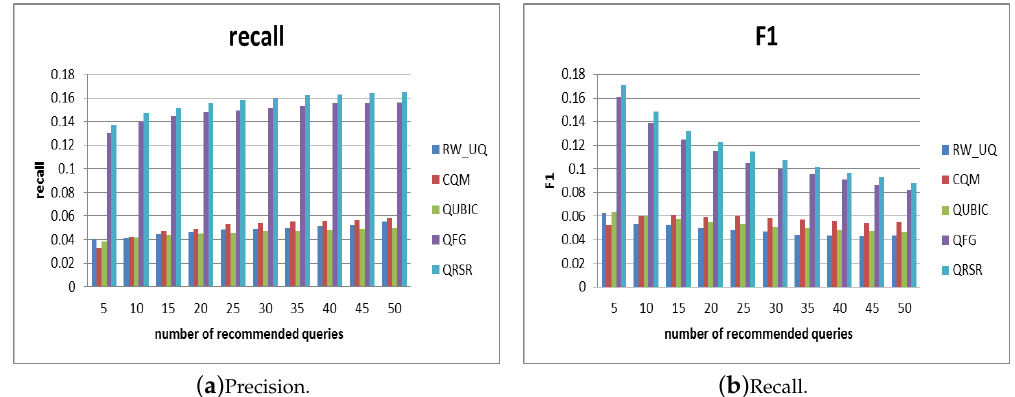
( a ) Precision. ( b ) Recall. Figure 9. Compare recall and F1 with other algorithms. ( a ) Description of recall in the first panel. ( b ) Description of F1 in the second